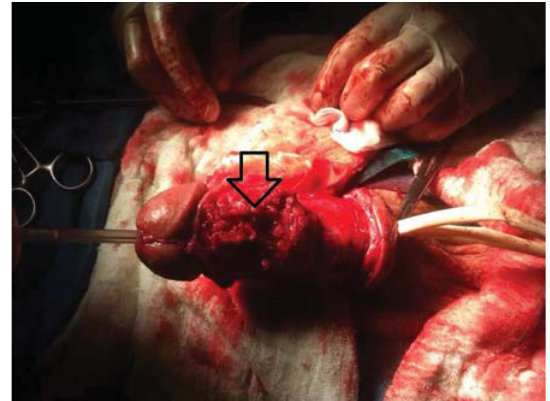
Figure 1b - Appearance of the penis 2 days after the